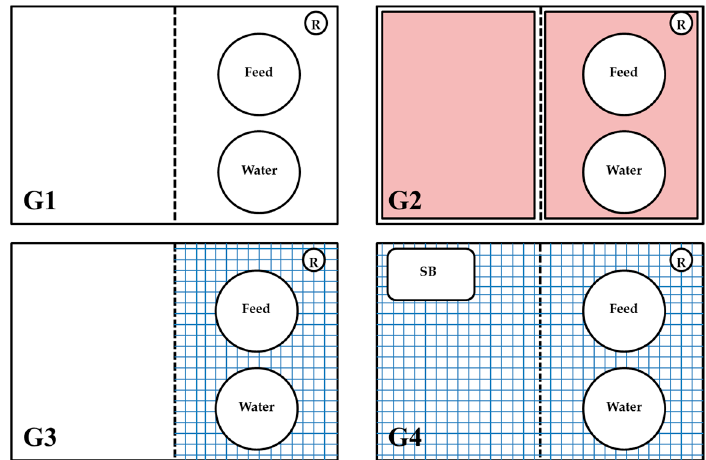
Figure 1. Flooring designs used in the study: G1 = entire floor pen with litter; G2 = identical to G1 and additionally having floor heating (in red); G3 = plastic covered steel slats in 50% of the pen (in blue) as well as an area with litter; G4 = fully-slatted flooring with plastic covered steel slats and a sand bath (900 cm 2 ). SB = sand bath, R = rope.